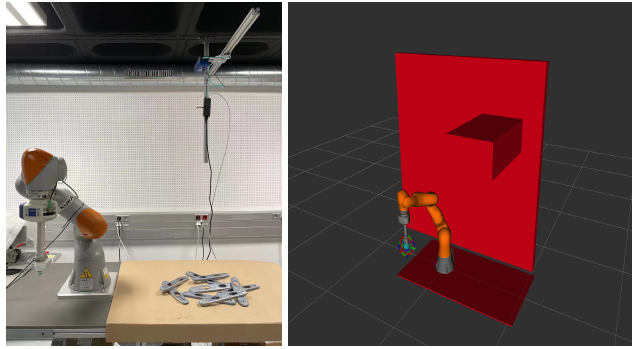
Figure 6. The environment setup for Use Case 1, left : the real scene, right : the virtual scene where obstacles are broadened for safety reasons.